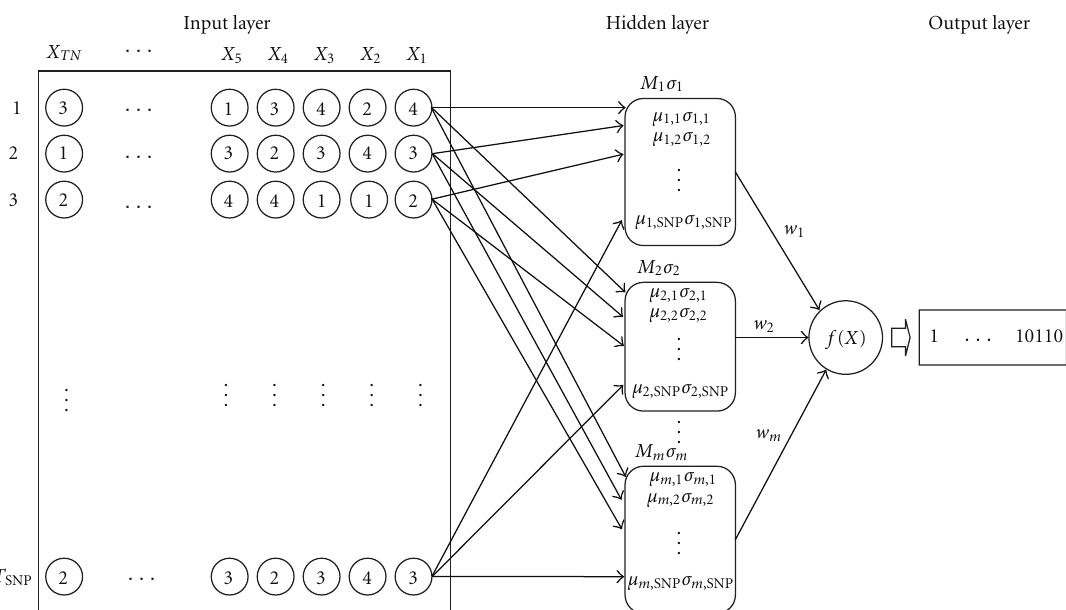
Figure 1: RBF network representation of the relations between individual mtSNPs and the AD patients. The input layer is the set of mtSNP sequences represented numerically (A, G, C, and T are converted to 1, 2, 3, and 4). The hidden layer classifies the input vectors into several clusters according to the similarities of individual input vectors. The determination of the output layer depends on which analysis is carried out. In the case of AD patients, 1 corresponds to AD patients and 0 corresponds to seven other classes of people. The other classes of people (PD patients, T2D patients, T2D patients with angiopathy, centenarians, semi-supercentenarians, non-obese young males, and obese young males) are carried out in a similar way. X i is the i th input vector, TN is the maximum number of vectors (in this example, TN = 523 (64 × 7+75 (112 × 2 / 3)), T SNP is the maximum number of mtSNPs (in this example, T SNP = 562), M m is the location vector, m is the number of basis functions, μ is the basis function, σ is the standard deviation, w i is the i th weighting variable, and f ( X ) is the weighted sum